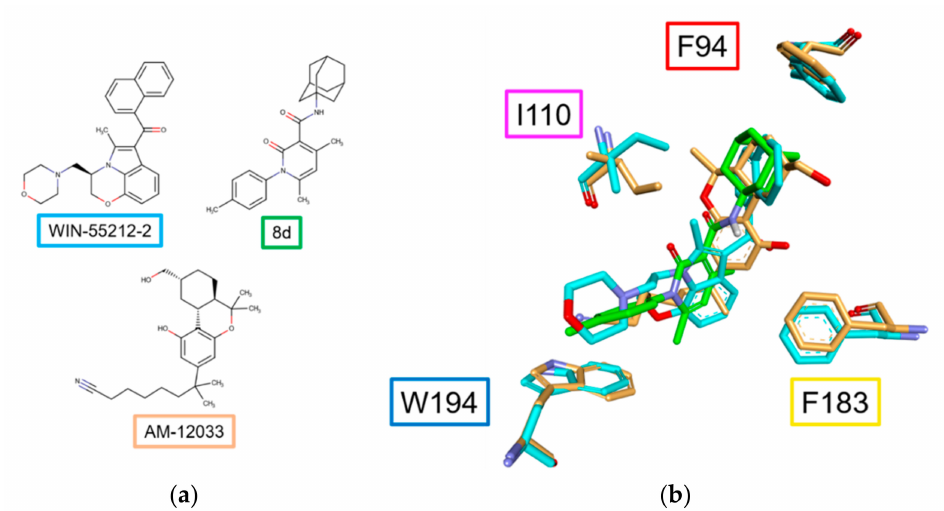
Figure 4. ( a ) Structurally different CB2R agonists; ( b ) Superposition of the CryoEM structure of CB2R with bound agonist WIN-55212-2 (PDB:6PT0, both cyan), the crystal structure of CB2R with the selective agonist AM12033 (PDB:6KPC, both orange) and the predicted binding pose of 8d (green). Residues F94 (red, cavity 1) W194 (blue, cavity 2), F183 (yellow, cavity 3) and I110 (magenta, common residue) are shown for spatial references.